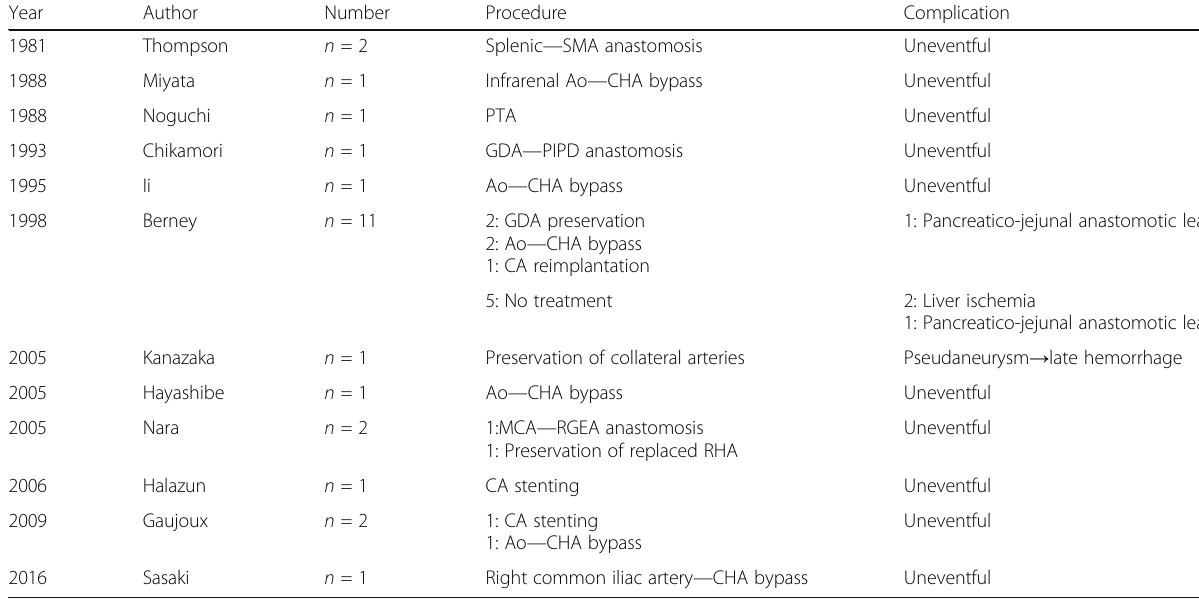
Table 1 Summary of CACS caused by sclerosis on previous literature